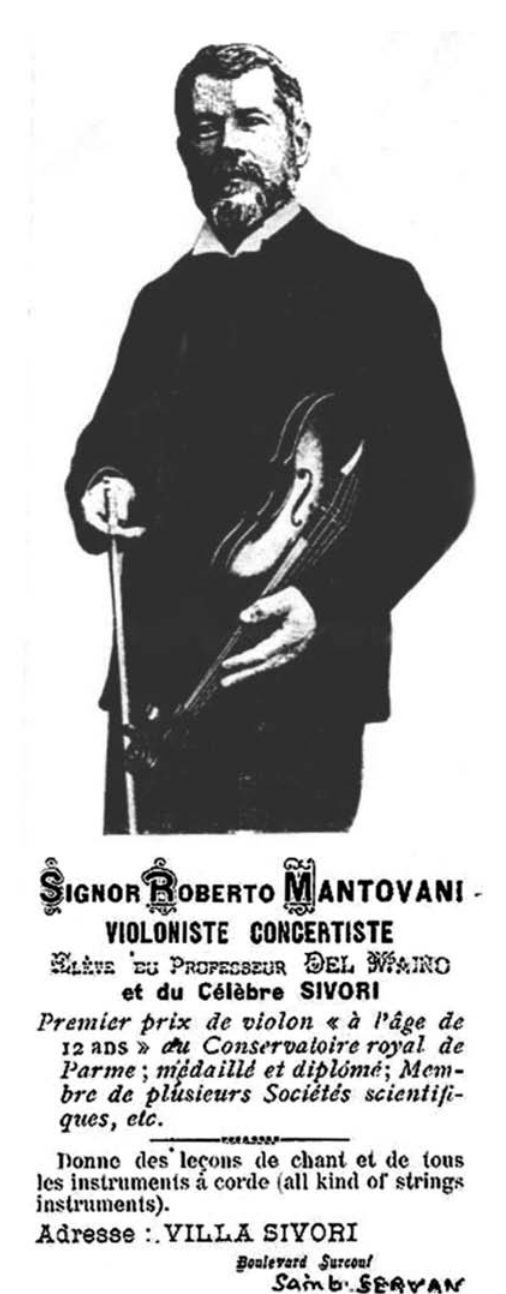
Fig. 1. Photographic portrait of Roberto Mantovani in a publicity of his Scool of Music in Saint Servan. It is the first page of a three folded